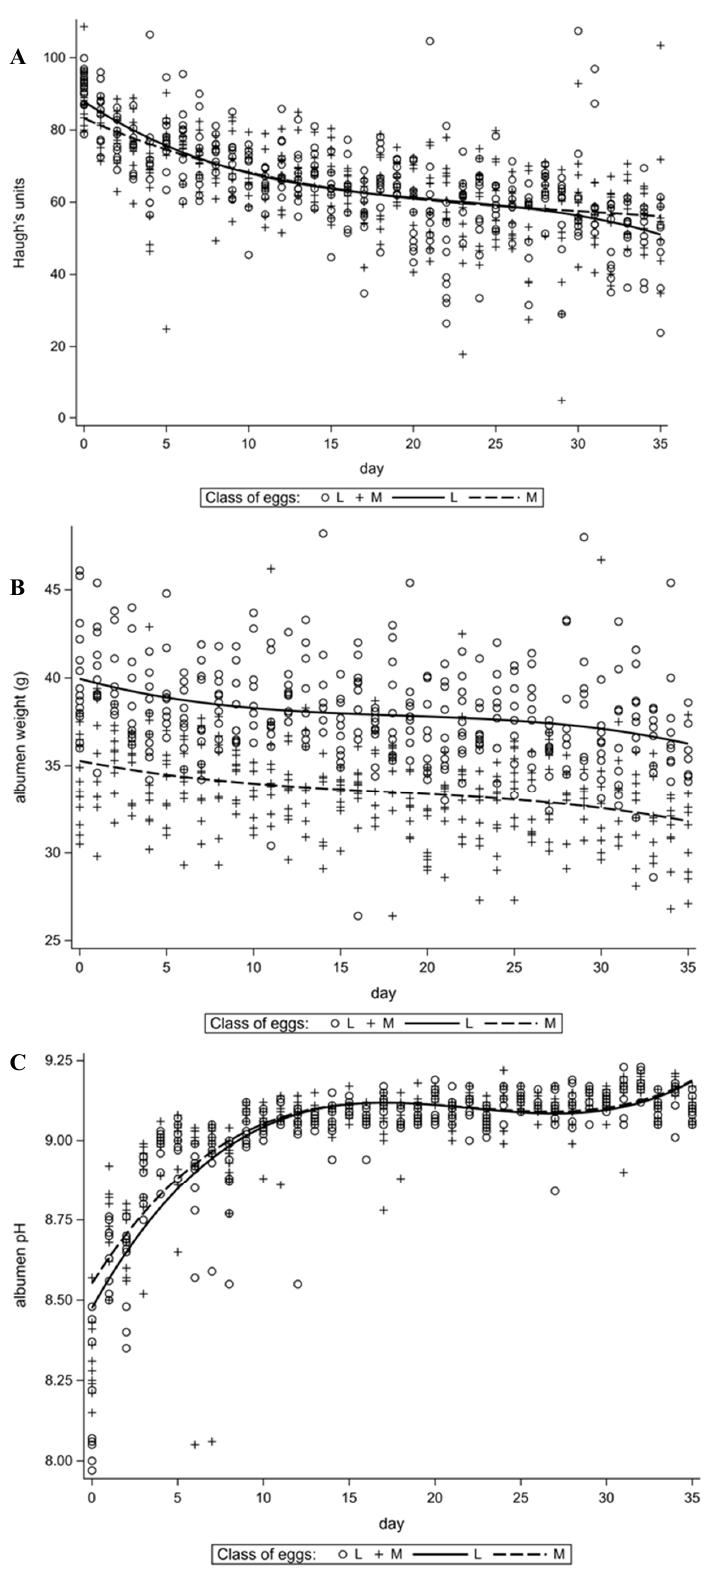
Figure 2. Changes in time of selected traits of egg albumen. ( A )—Haugh units (HU), ( B )—albumen weight (AW), ( C )—albumen pH (ApH).